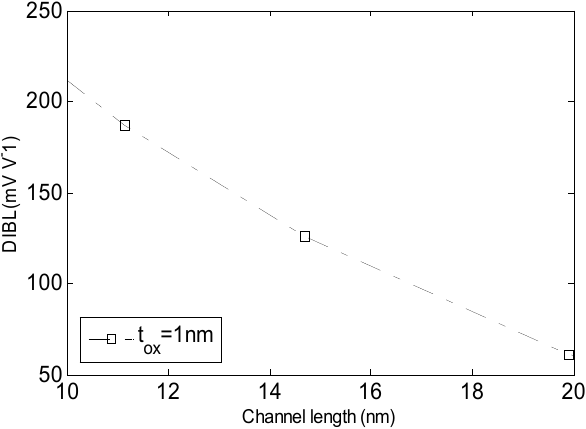
Figure 9. The drain induced barrier lowering dependence on the channel length.